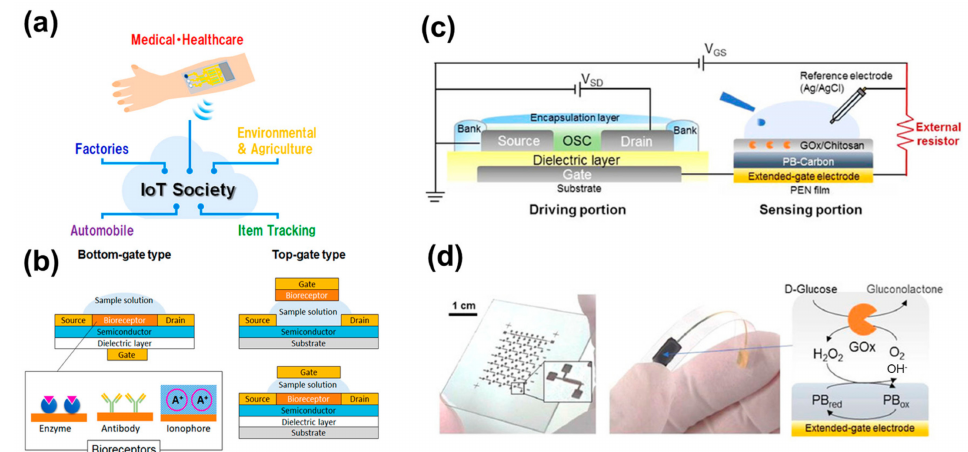
Figure 3. ( a ) The illustration of IoT technologies. ( b ) Based on the top of the grid and bottom gate transistor, the typical structure of biosensors. ( c ) Schematic representation of the structure of the enzyme sensor based on an extended-gate organic transistor. ( d ) The schematic diagram of the transistor array and the enzymatic reaction at the extended gate electrode. ( a ) Reproduced with permission [27]. Copyright 2022, Elsevier. ( b ) Reproduced with permission [27]. Copyright 2022, Elsevier. ( c ) Reproduced with permission [33]. Copyright 2018, John Wiley and Sons. ( d ) Reproduced with permission [33]. Copyright 2018, John Wiley and